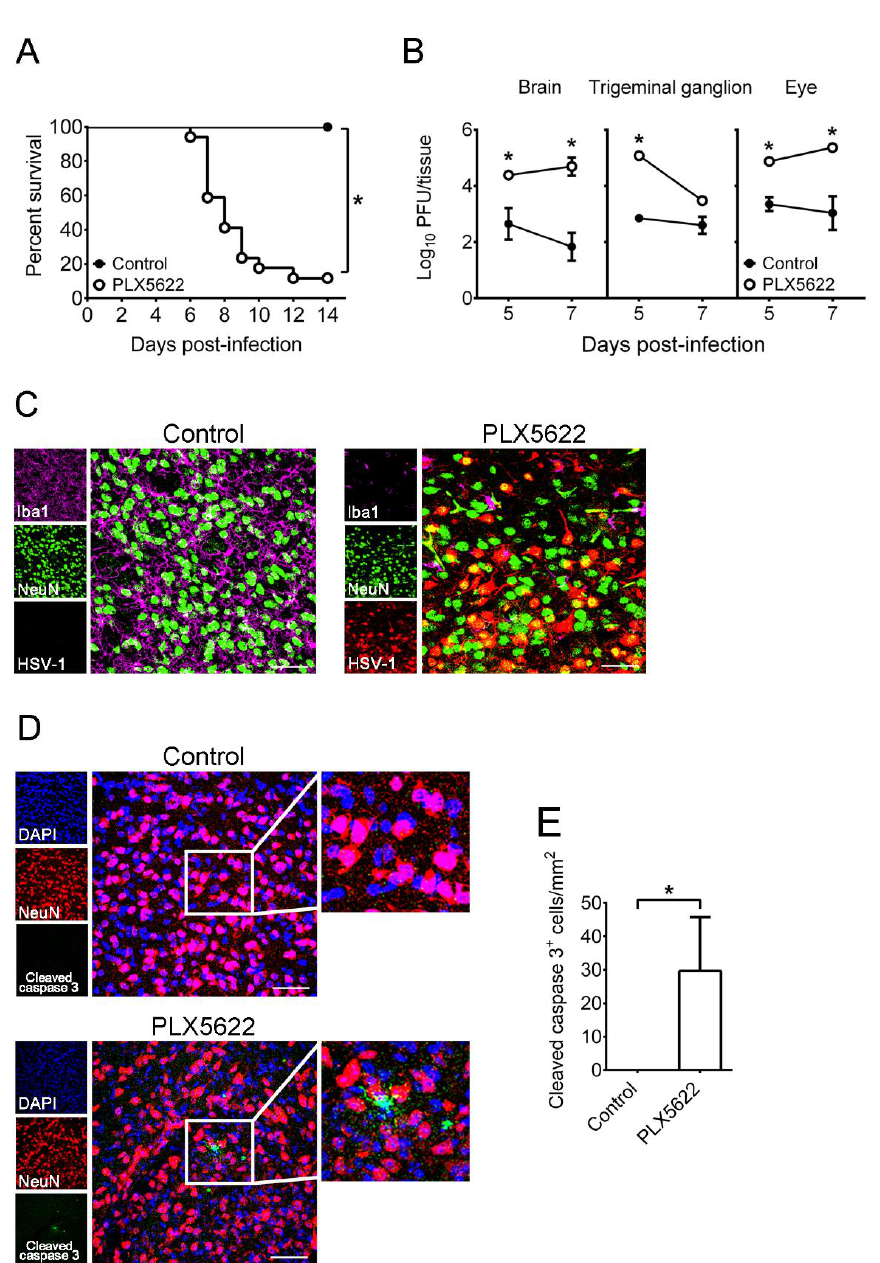
Figure 2. The effects of PLX5622 on HSV-1 lethality, tissue viral loads, and brain infected neurons as well as neuron apoptosis of mice. ( A ) Mice were fed with control chow (n = 16) or the chow containing PLX5622 (n = 17), infected with HSV-1, and monitored for survival. ( B ) The indicated organs and tissues of control and PLX5622-treated mice were harvested on the indicated days for virus titration and on day 7 post-infection for brain sections ( C,D ) before immunofluorescence staining with antibodies against Iba1, NeuN, HSV- 1, or cleaved caspase 3. Scale bar, 50 μm. In panel C , right panels are the merged and magnified images of three left panels. In panel D , middle panels are the merged and magnified images of three left panels, and right panels are the magnified images of indicated areas show in middle panels. ( E ) The number of leaved caspase 3 + cells in images (0.3 × 0.3 mm) were counted. Results shown in panels ( C – E ) are the temporal region and the representative of at least 3 samples per group from two independent experiments. The data represent means ± SEM (error bars) of 3–6 samples per data point obtained from at least two independent experiments in panels ( B , E ). *, p < 0.05, compared between the indicated groups ( A , E ) or with the control group on the same day ( B